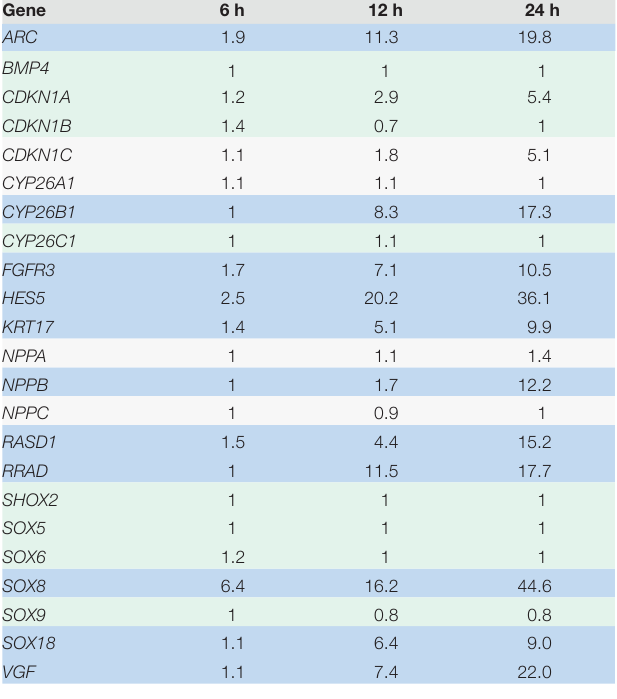
TABLE 1 | Genes selected for